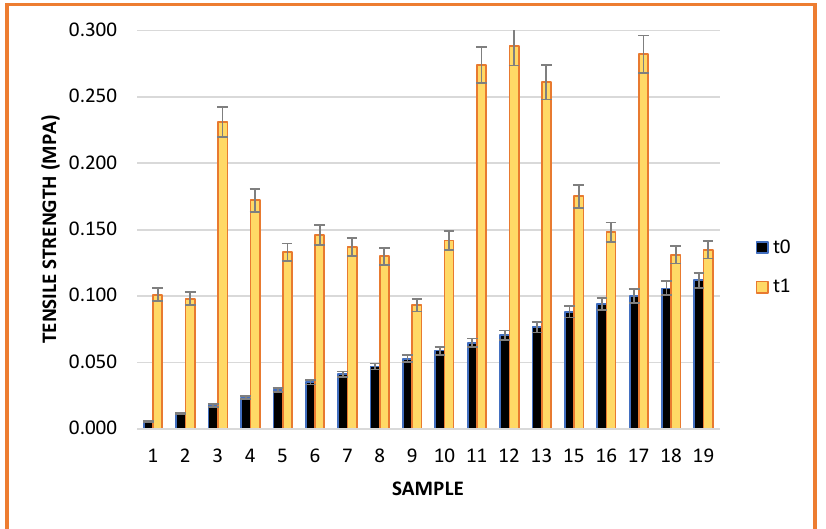
Figure 5. Sample tensile strength.